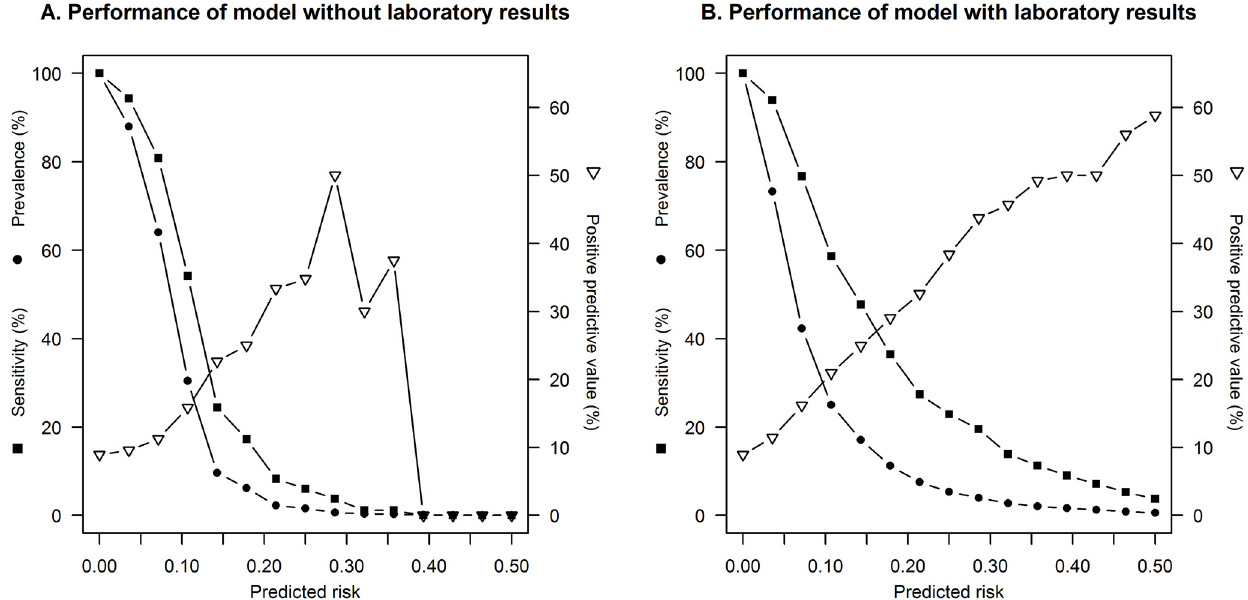
Fig 1. Performance of the model without (A) and with (B) laboratory results. For different cut-off values of the predicted risk, the prevalence of having an equal or higher risk, the sensitivity of this cut-off value, and the positive predictive value are